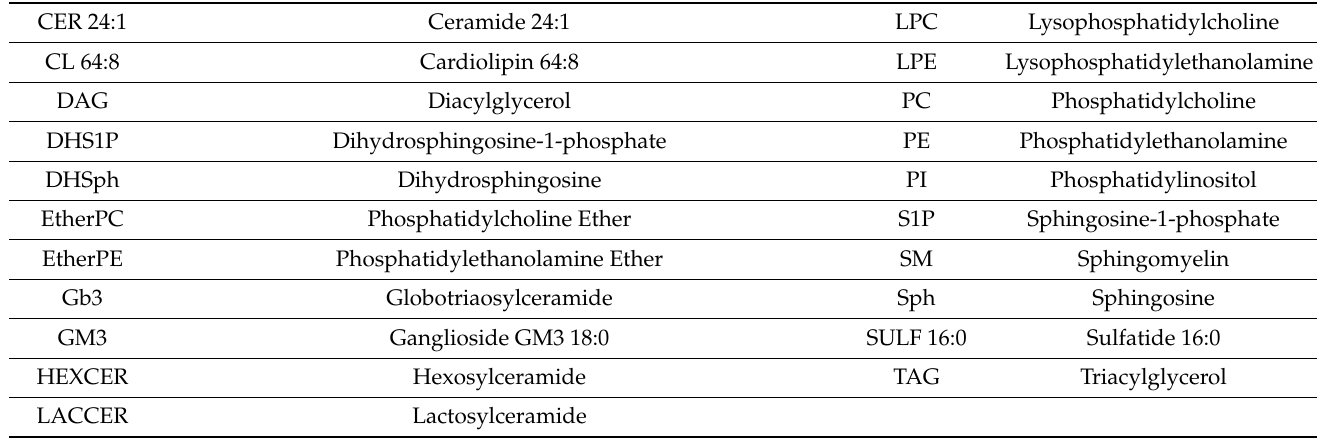
Table 1. Nomenclature of lipid species in MA plasma lipidomics.